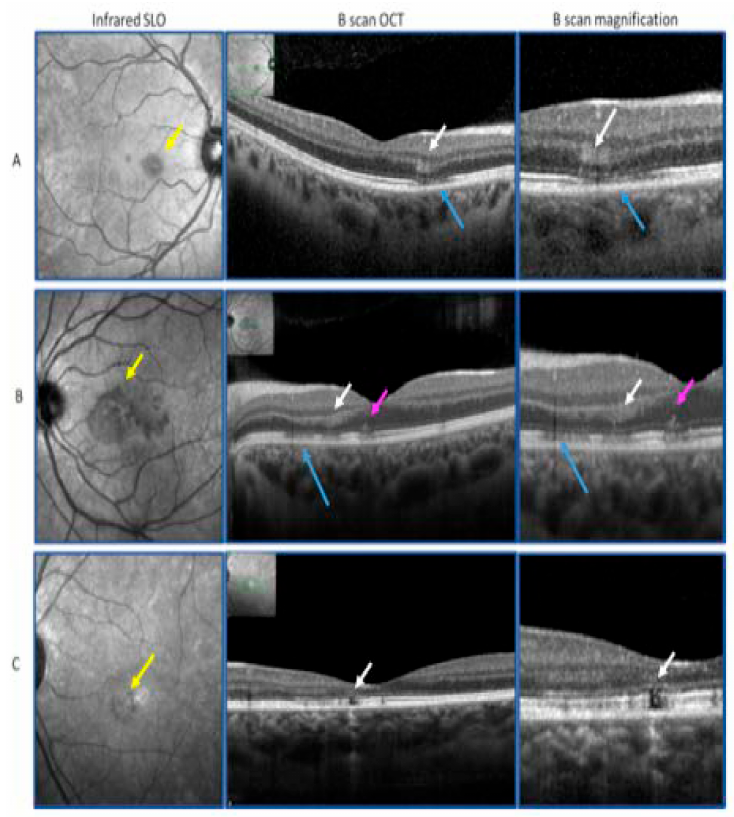
Figure 1. ( A ): “Classical” acute macular neuroretinopathy (AMN) with a petaloid, sharp border, lesion on infrared scanning laser ophthalmoscopy (SLO) (yellow arrow), corresponding to an outer plexiform layer (OPL) hyper-reflectivity on optical coherence tomography (OCT) (Heidelberg En- gineering, V1.10.12.0, 69115 Heidelberg, Germany) B-scan (white arrows), and with extrafoveal ellipsoid zone (EZ) disruption (blue arrows). ( B ): AMN “plus” with “photoreceptoritis” with a petaloid, fluffy border, lesion on infrared SLO (yellow arrow) corresponding to OCT B-scan OPL hyper-reflectivity (white arrows), and EZ disruption observed in the foveal center (pink arrows). ( C ): AMN “plus” with “photoreceptoritis” and “retinal pigment epithelitis”: infrared SLO lesion (yellow arrow) with retinal pigment epithelium (RPE) atrophy on OCT B-scan (white arrows).